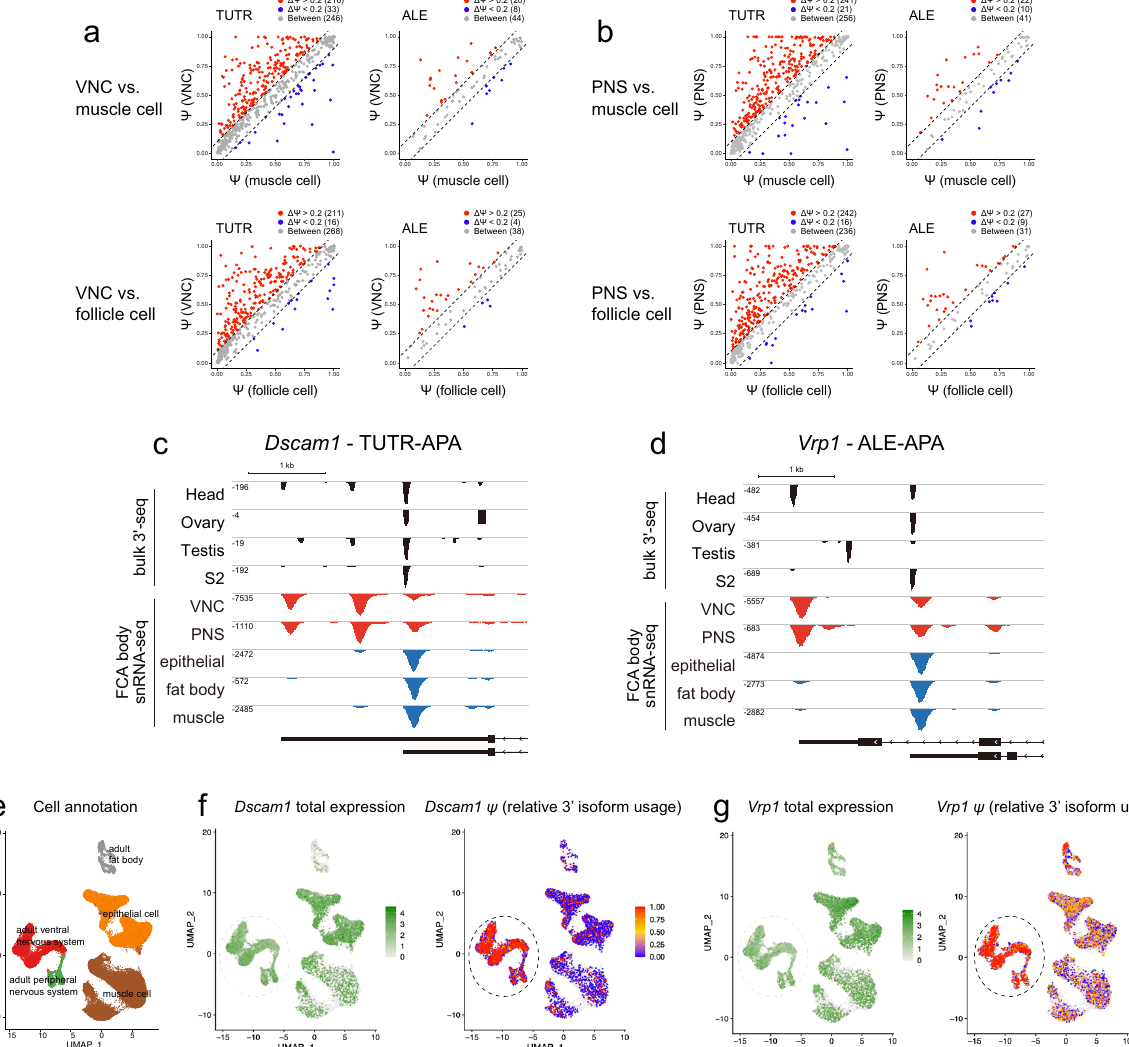
Fig. 3 | Diverse neuron types broadly implement distal ALE isoforms and extended3 ’ UTRs.a , b Using thebodysNuc-seqdataset,weused classi fi cationsof ventral nerve cord (VNC) (part of the central nervous system, CNS) and peripheral nervous system (PNS) and compared these to non-neural cell types (muscle and follicle cells shown here, others are shown in Supplementary Fig. 2). In all these comparisons, it is apparent that CNS ( a ) and PNS ( b ) neurons have unidirectional preference to express longer tandem 3 ’ UTRs as well as distal ALE isoforms. c , d Genome browser tracks of individual genes highlights that the preferential